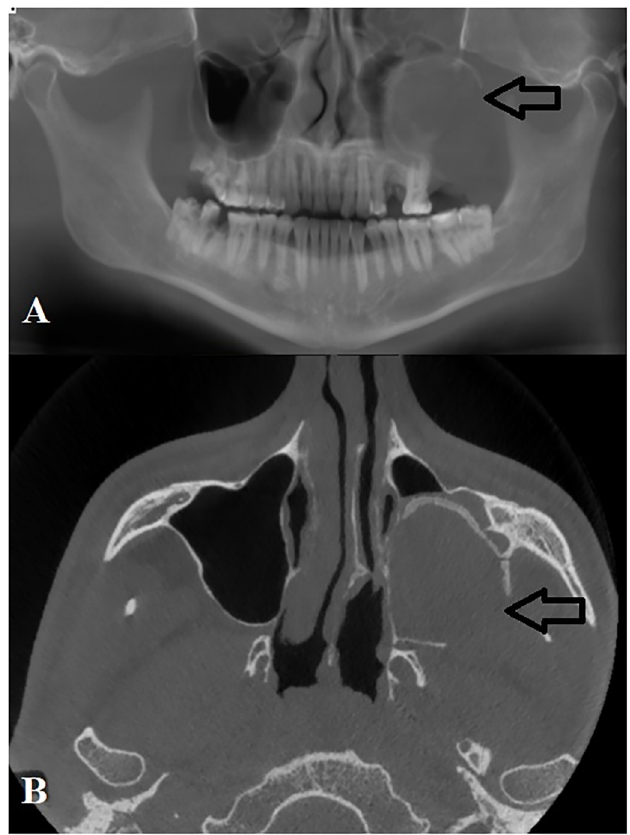
Fig 4. A : Panoramic reconstruction of cone beam computed tomography (CBCT) images of large residual cyst in the left maxilla that recurred following enucleation due to extension into maxillary antrum. B : Axial view of same patient showing residual cyst occupying the entire left maxillary